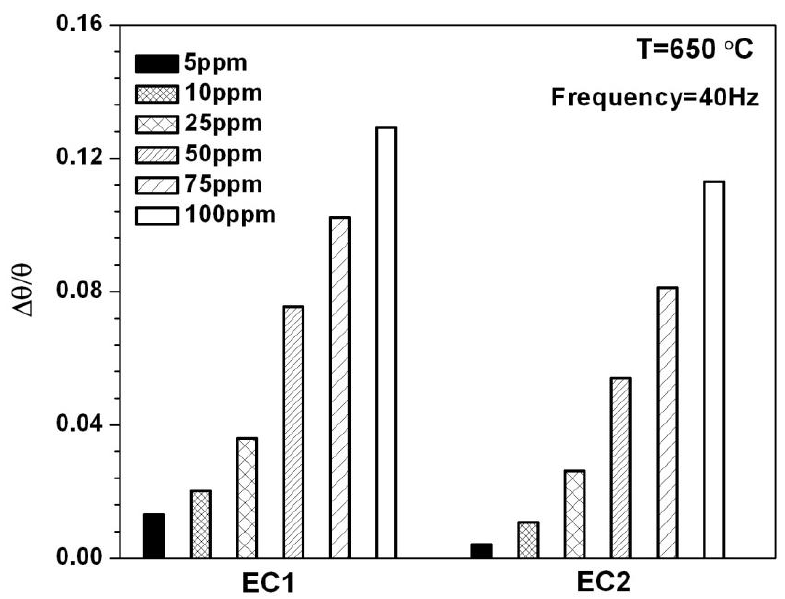
Figure 5. The change in the angular phase angle is plotted for EC1 and EC2 sensors for NO concentrations ranging from 5 to 100